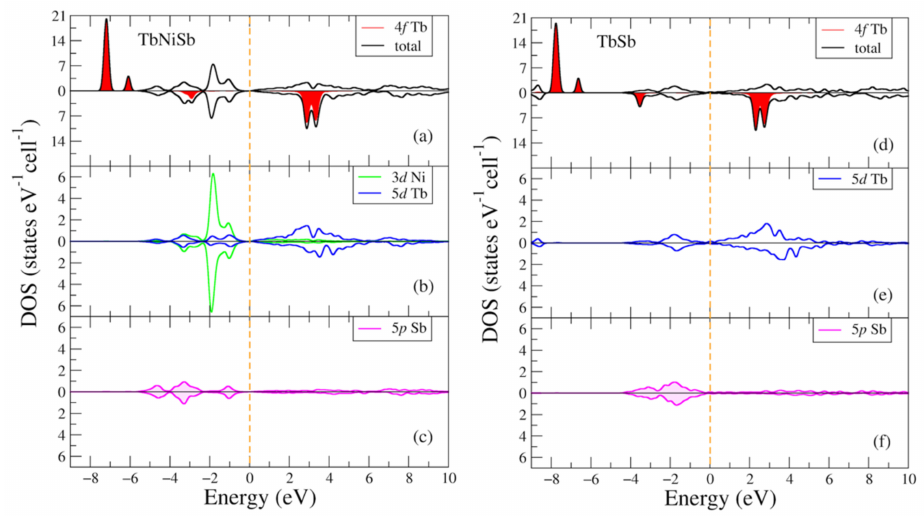
Figure 2. Densities of electronic states from DFT+U for ( a – c ) TbNiSb; ( d – f ) TbSb. ( a , d ) Total and partial Tb-4f densities of states; ( b , e ) Partial density of states for Tb-5d (Ni-3d); ( c , f ) Partial density of states for Sb-5p. The plot is shifted relatively to the Fermi energy shown at zero as a vertical